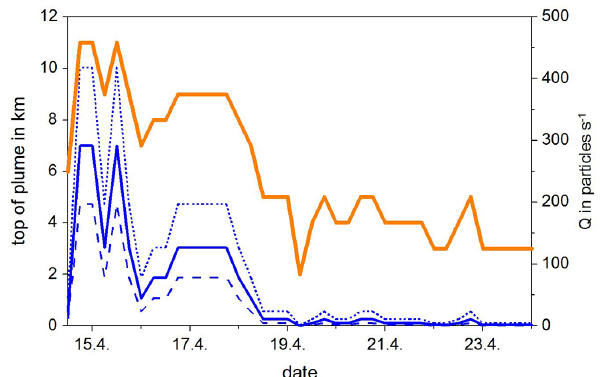
Figure 1. Temporal development of the height of the top of the plume in April 2010 at Eyjafjallajökull as used in the simulation (brown). Data was obtained from the reports of VAAC London. The blue lines give the source strength (solid: reference case, dotted: plume height increased by 1km, dashed: plume height decreased by